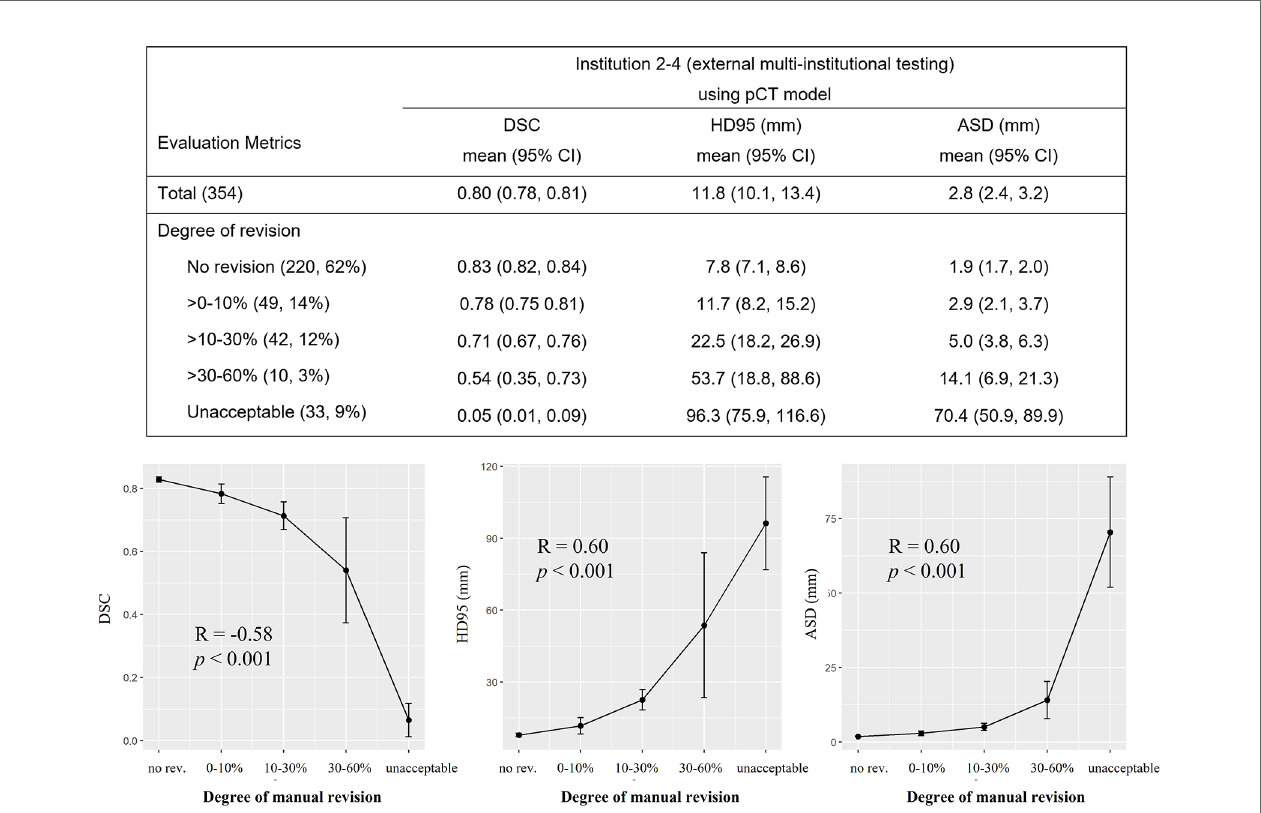
FIGURE 3 | Expert assessment of manual revision degree of the deep model-predicted contours. Table in the top row summarized the mean and 95% con fi dence interval (CI) of Dice similarity coef fi cient (DSC), 95% Hausdorff distance (HD95), and average surface distance (ASD) strati fi ed by different degrees of manual revision. The correlations between the mean of DSC, HD95, ASD, and the degree of manual revision were plotted in the bottom row. Spearman correlation coef fi cient showed that DSC and degree of manual revision were correlated (R = -0.58, p < 0.001). Same correlation was observed for the HD95 and ASD (HD95: R = 0.60, p < 0.001; ASD: R = 0.60, p < 0.001). Degree of manual revision was de fi ned as the percentage of gross tumor volume (GTV) slices that needed modi fi cation for clinical acceptance. pCT, treatment planning